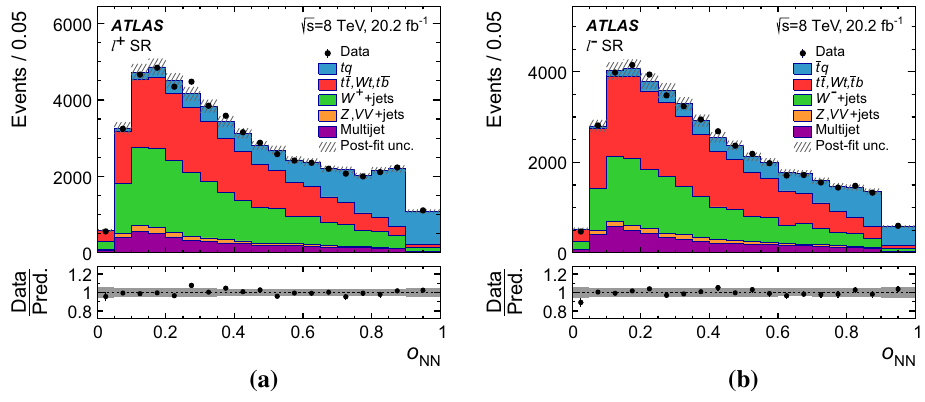
Fig. 6 Observed O NN distributions in a the (cid:5) + SR and in b the (cid:5) − SR compared to the model obtained from simulated events. The simulated distributions are normalised to the event rates obtained by the fit to the discriminants. The hatched uncertainty band represents the total uncer-